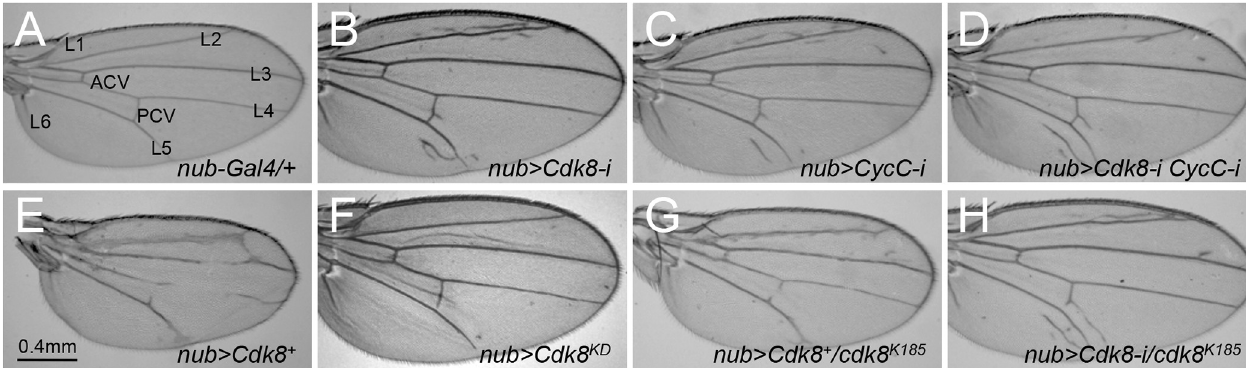
Fig 1. Wing vein patterning defects caused by varying the levels of CDK8, CycC, or both. Adult female wings of (A) nub-Gal4/+ (control), note the longitudinal veins L1-L6, anterior crossvein (ACV), and posterior crossvein (PCV); (B) w 1118 /+; nub-Gal4/+; UAS-Cdk8-RNAi/+ ; (C) w 1118 /+; nub-Gal4/+; UAS-CycC-RNAi/+ ; (D) w 1118 /+; nub-Gal4/+; UAS-Cdk8-RNAi CycC-RNAi/+ ; (E) w 1118 /+; nub-Gal4 > UAS-Cdk8 + /+ ; (F) w 1118 /+; nub-Gal4/UAS-Cdk8 KD ; (G) w 1118 /+; nub-Gal4 > UAS-Cdk8 + /+; cdk8 K185 ; and (H) w 1118 /+; nub-Gal4/+; UAS-Cdk8-RNAi/cdk8 K185 .